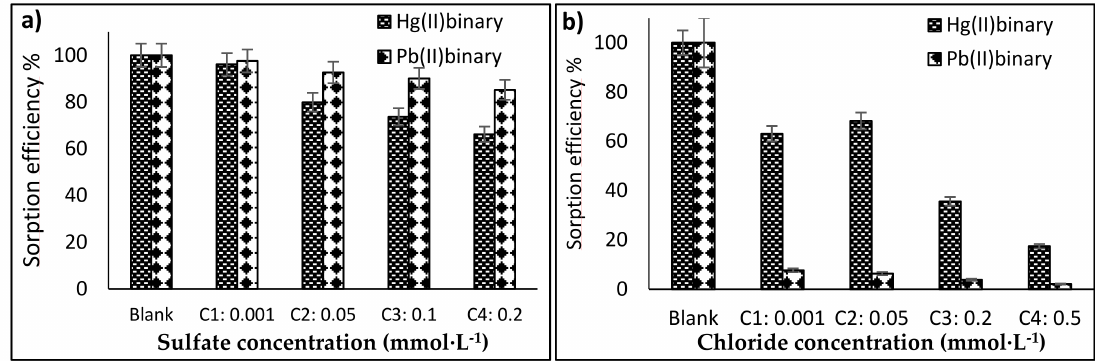
Figure 9. Salt effects: ( a ) Sulfate effect, ( b ) Chloride effect. ( T : 20 ◦ C; sorbent dosage: 0.2 g · L − 1 ;